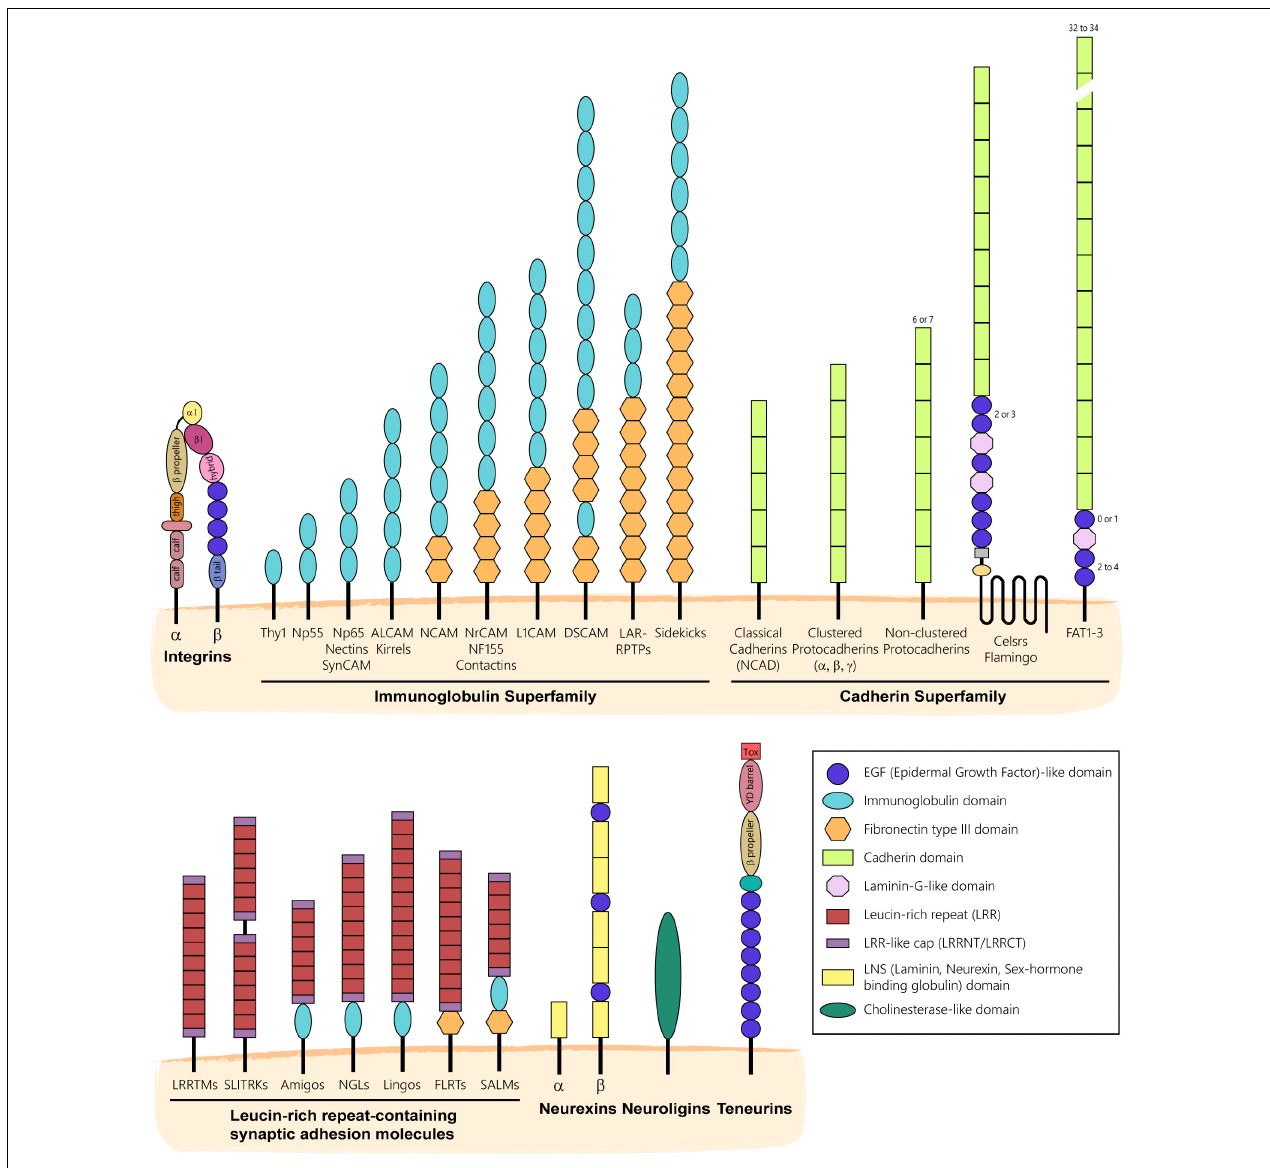
FIGURE 1 | Main families of CAMs expressed in the nervous system. CAMs have historically been classified into families based on the structural composition of their extracellular domain. Integrins form obligate heterodimers composed of α and β integrin subunits that cluster at the plasma membrane to mediate adhesion to the extracellular matrix. CAMs of the Immunoglobulin Superfamily (IgSF) are characterized by the presence of one or more Ig-like domains that can be followed by Fibronectin type III domain (Fn3) repeats. IgSF CAMs mediate adhesion by engaging in homophilic or heterophilic interactions. Most of them include a transmembrane and intracellular domains, but some like Contactins are GPI-anchored. CAMs of the Cadherin Superfamily mostly engage in homophilic interactions and are characterized by the presence of one or more calcium-binding cadherin repeats. The Leucine-rich repeat (LRR) Superfamily includes adhesion molecules that are characterized by the presence or LRRs and can include Ig or Fn3 domains in their extracellular domain. LRR CAMs are often found at synapses and engage in both homophilic or heterophilic trans -interactions. Neurexins and Neuroligins engage in heterophilic interactions in trans at nascent synapses to promote synaptic differentiation and stabilization. Teneurins are type II single-pass transmembrane proteins that interact homophilically or engage in trans -interactions with Latrophilins, a class of adhesion G-protein coupled receptors (not